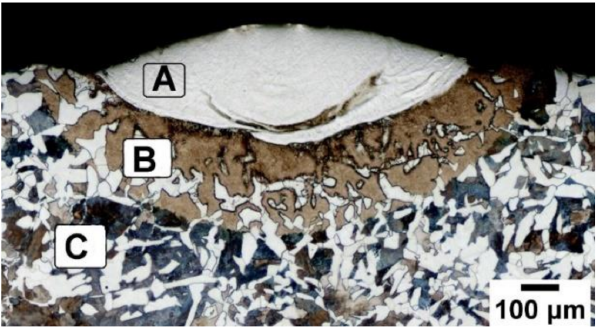
Figure 4. Transverse sectional optical image of the